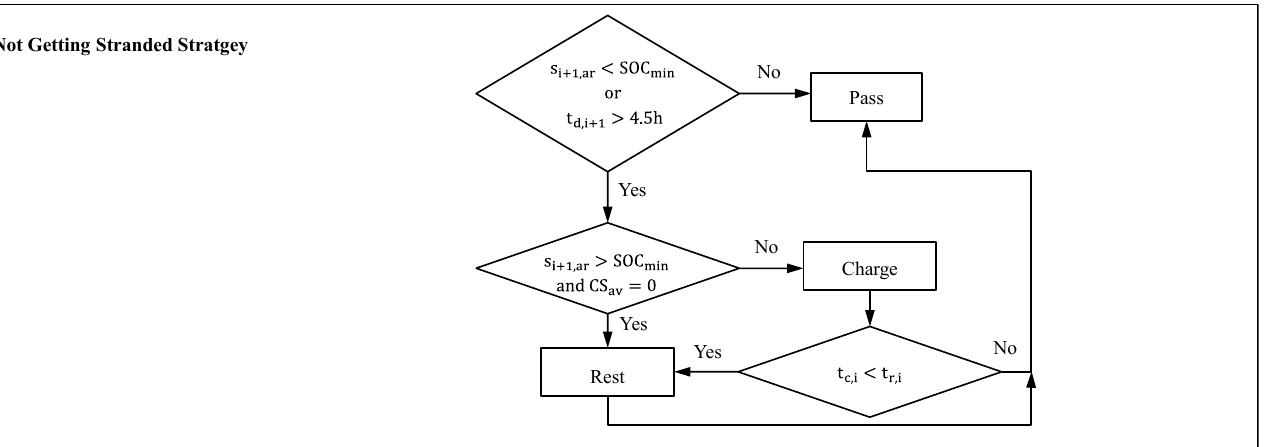
is is less s i+1,ar t d,i+1